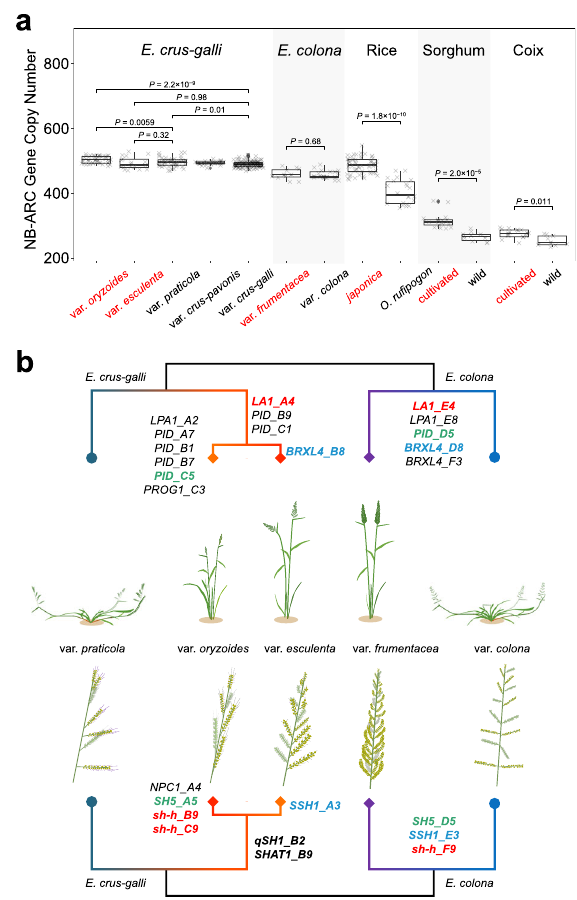
Fig. 5 Domestication of barnyard millets. a Alteration of the NB-ARC gene family size during domestication for fi ve crops (two barnyard millets, rice, sorghum and coix). E. crus-galli : n = 43 oryzoides , n = 18 esculenta , n = 48 praticola , n = 22 crus-pavonis , n = 115 crus-galli ; E. colona : n = 11 frumentacea , n = 19 colona ; rice: n = 55 japonica , n = 22 wild; sorghum: n = 18 cultivated, n = 10 wild; Coix: n = 18 cultivated, n = 9 wild. In the box plots, the horizontal line shows the median value, and the whiskers show the 25% and 75% quartile values of NB-ARC gene copy numbers in fi ve species. P values are calculated using the two-tailed Wilcoxon test. b Genomic divergence of key genes regulating plant architecture and grain shattering between barnyard millets and grasses. Chromosome IDs are indicated after the gene names. For example, ‘ LA1_A4 ’ represents the gene LA1 on chromosome AH04. Source data are provided as a Source data fi